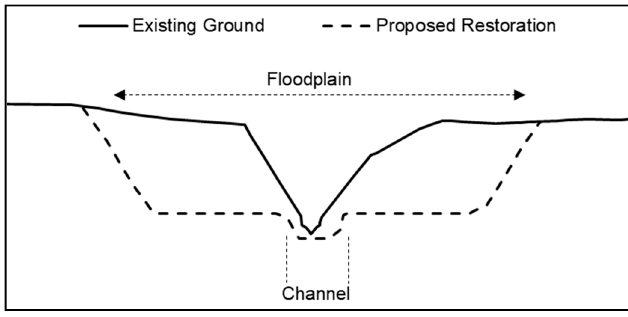
Figure 4. Typical cross section modification for floodplain restoration.